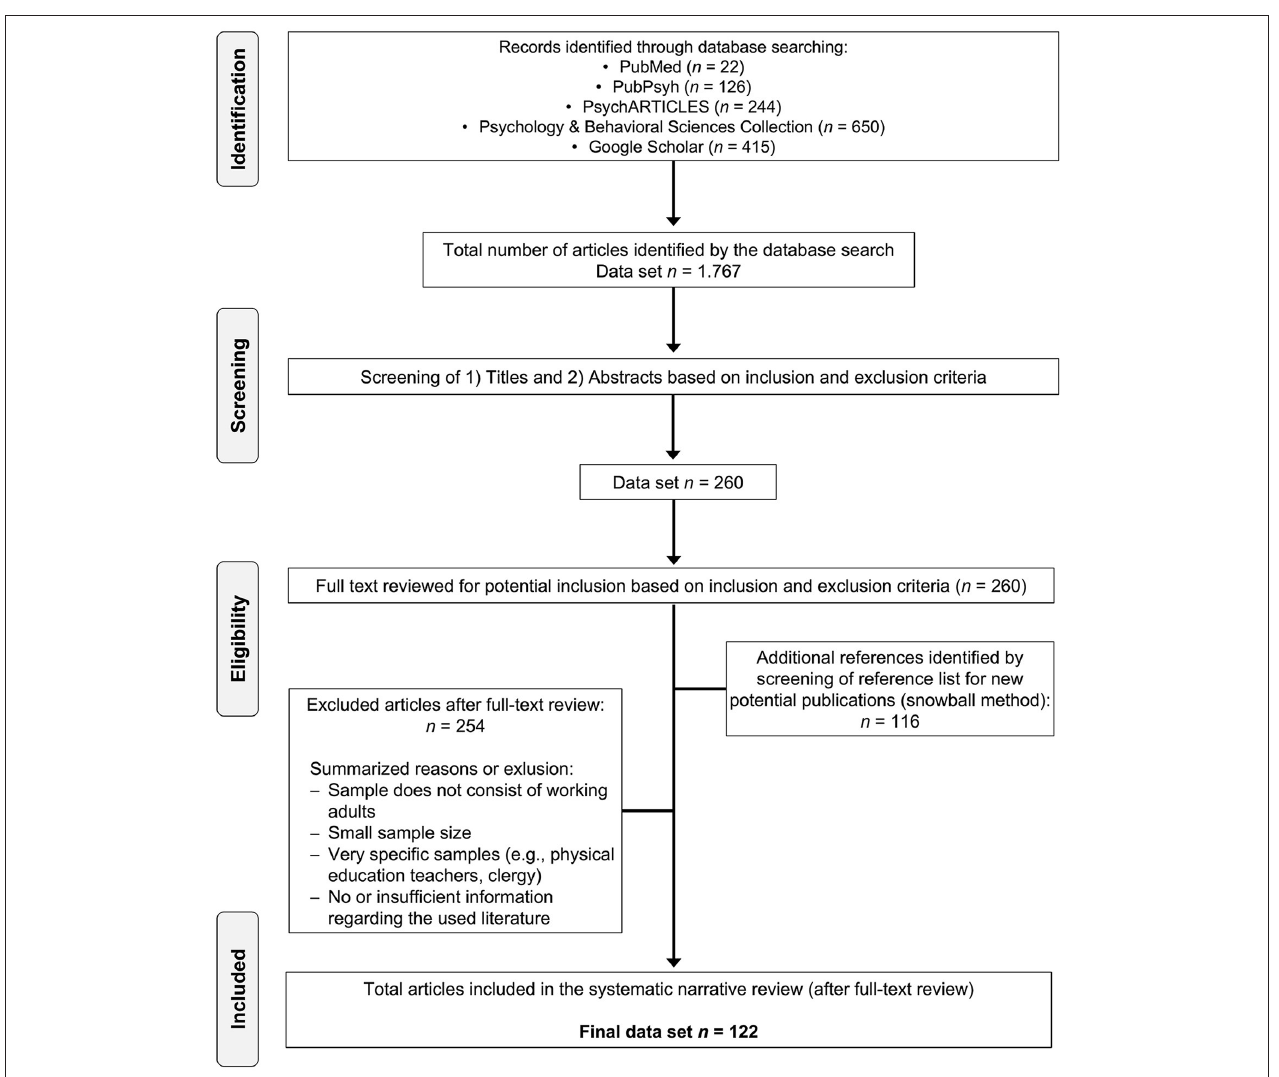
FIGURE 1 | PRISMA flow diagram of the systematic literature selection